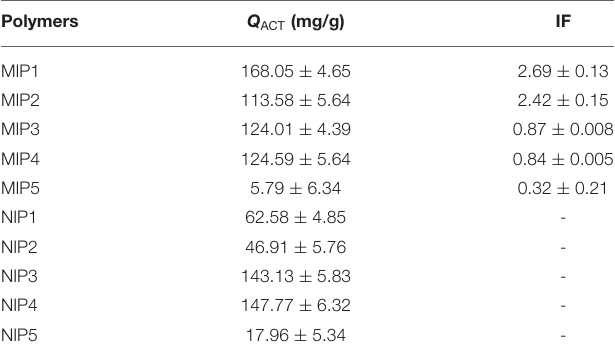
TABLE 5 | Adsorption data of MIPs and NIPs.